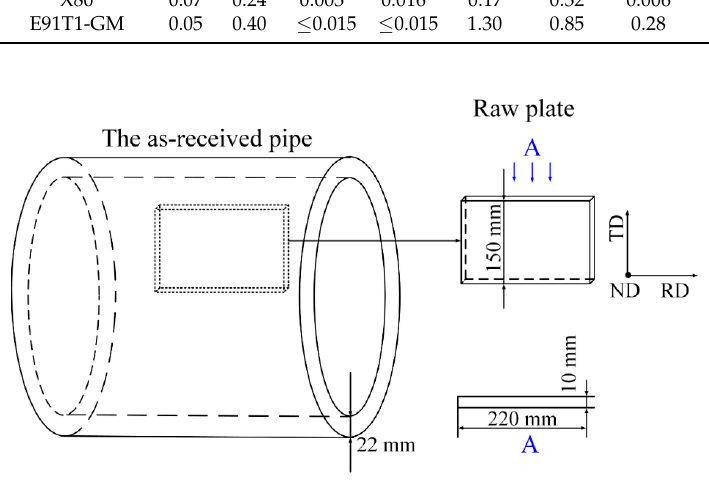
Figure 1. Sampling methods and main dimensions of the raw plates.